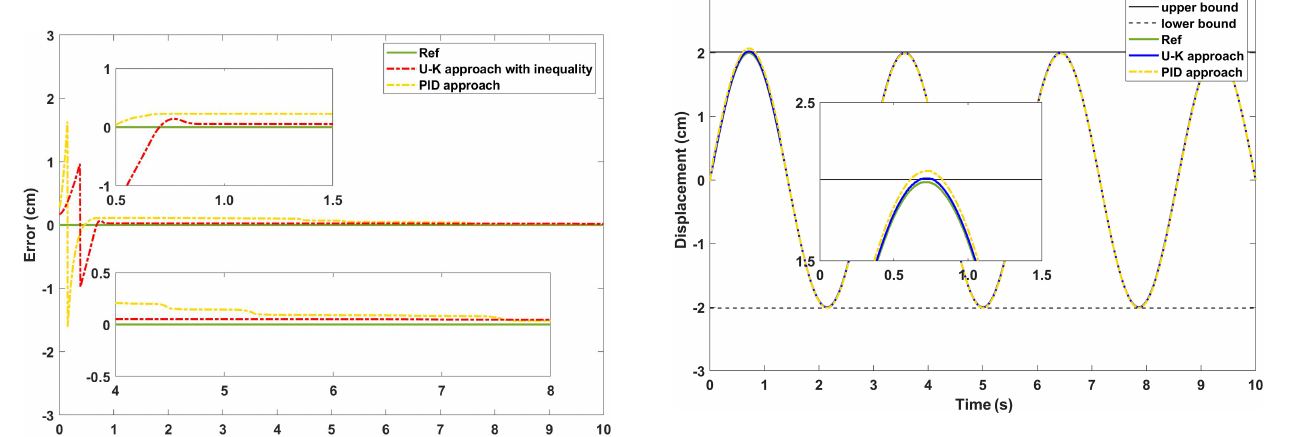
Figure 13. The experimental results of the steady-state perfor- mance of the U–K equality constraint and